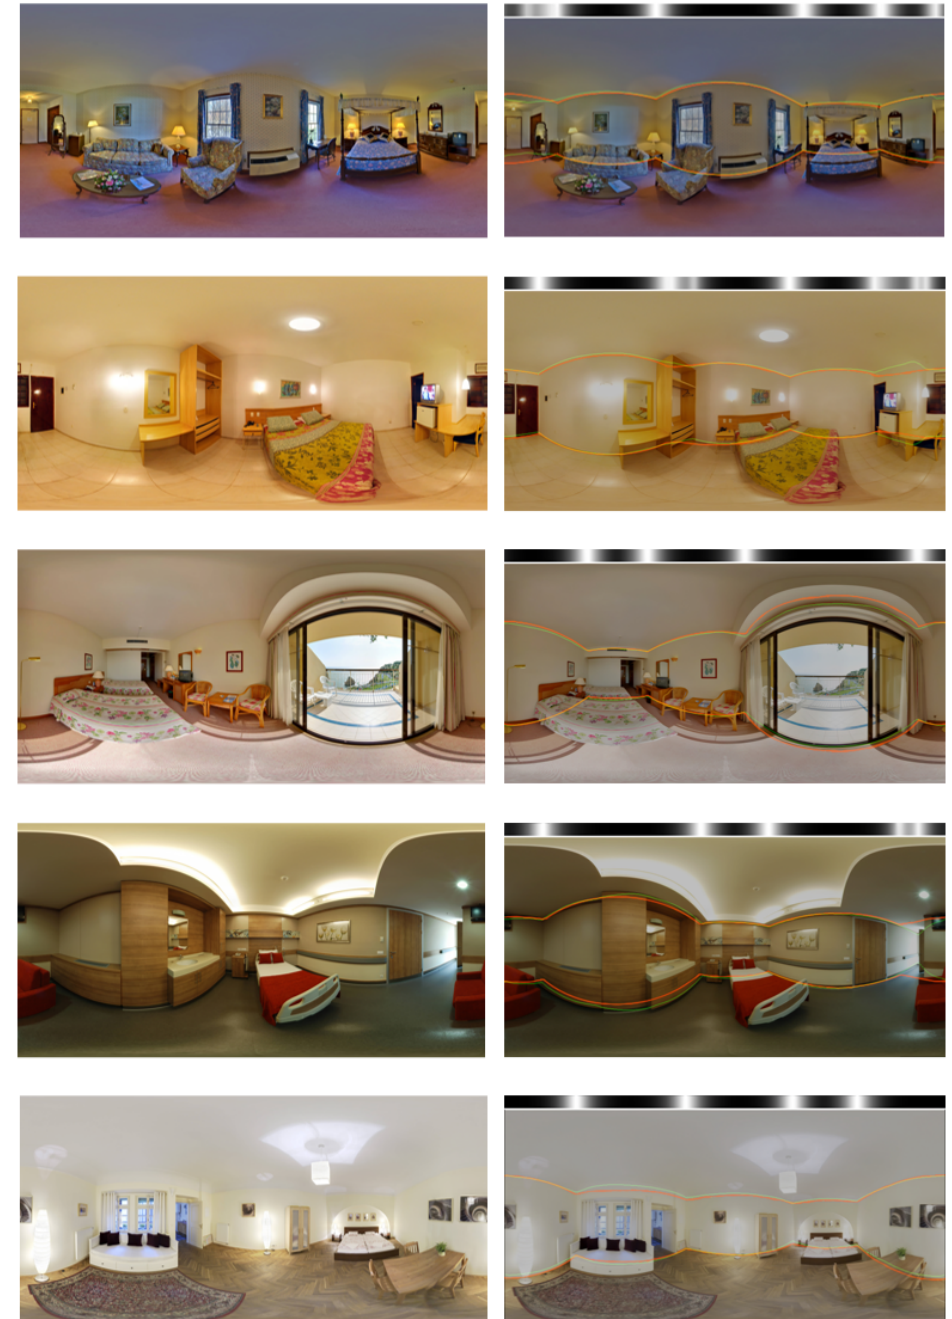
Figure 7. Multiple layout estimates generated by MreNet (green) and HorizonNet